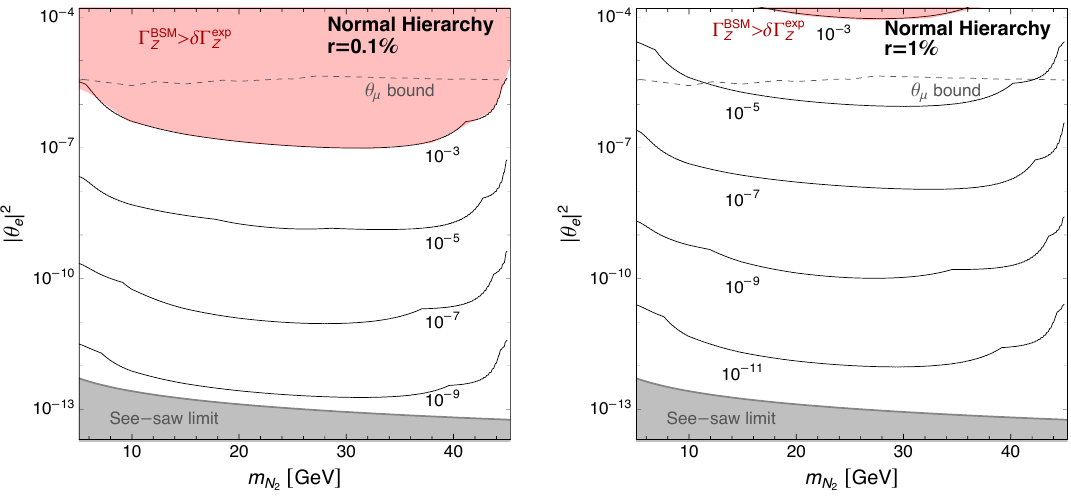
Figure 9 . Isocontour of equal partial widths for N 2 → N 1 γ and N 2 decaying via mixing for various choices of BR( Z → N 1 N 2 ) . We fix the relative mass splitting between N 2 and N 1 to 0.1% (left) and 1% (right). Above the lines, for that specific BR( Z → N 1 N 2 ) , the decay via mixing dominates. In the red shaded area Γ BSM is larger than the current experimental uncertainty on the Z boson Z total width. The gray dashed line represents the limit on the mixing angle arising from existing experimental searches. In the gray shaded region the lightness of the neutrino masses cannot be explained by the see-saw